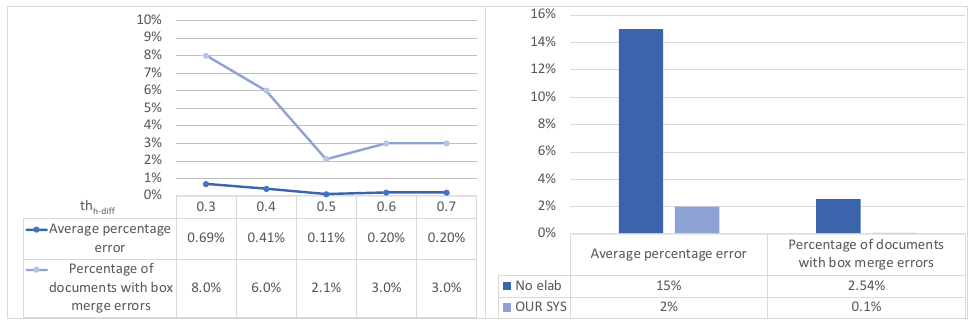
Figure 10. Text-region merging: effect of height-difference threshold th h-diff ( left ) and error compari- son with and without merging ( right